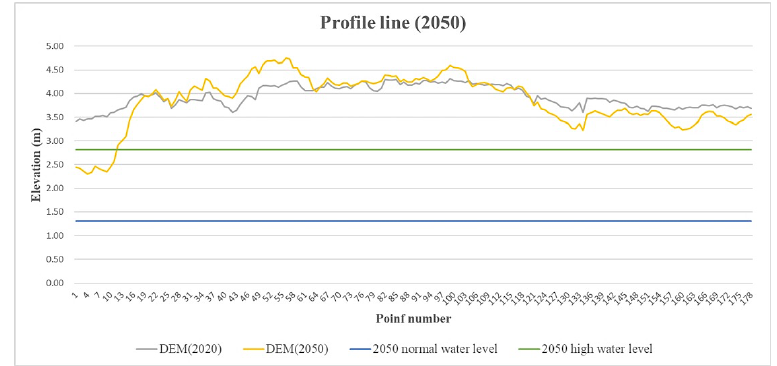
Figure 28. Static display of dam profile and sea-level in 2050. The highest sea-level is 2.81 m and the normal sea-level is 1.31 m.